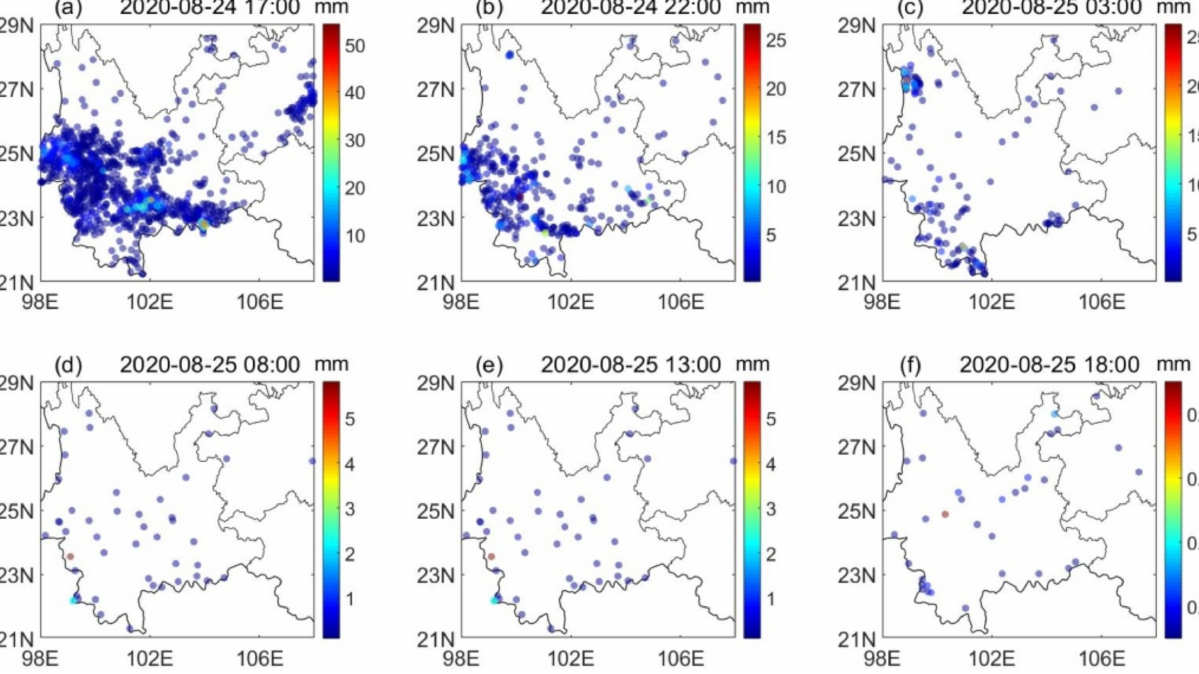
Figure 12. Precipitation at stations in Yunnan–Guizhou Plateau from 17:00 on 24 August (UTC) to 18:00 on 25 August 2020 (scattered points represent stations with precipitation greater than, and color scales represent the amount of precipitation. ( a – f ) represent the results of 5 h